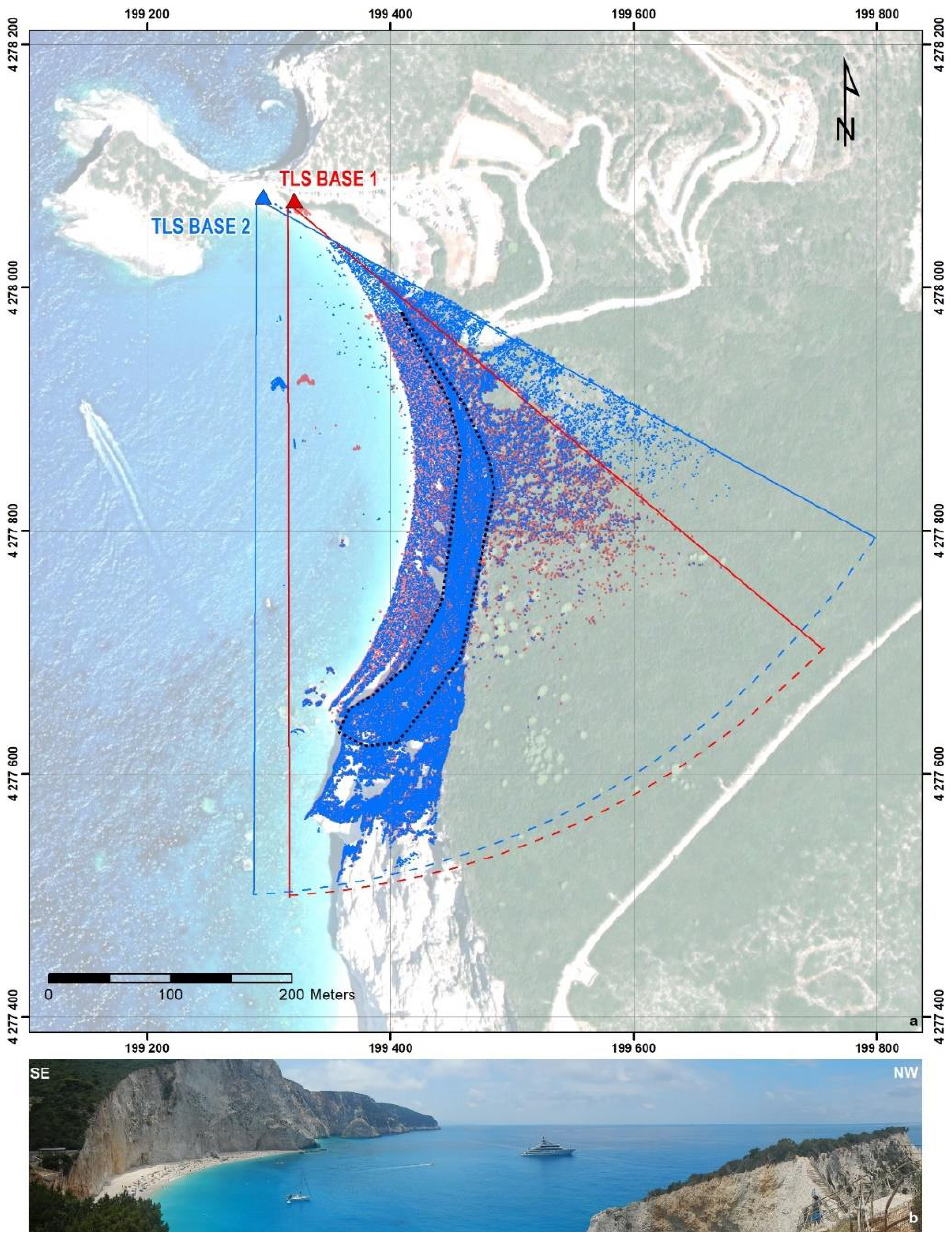
Figure 6. ( a ) Spatial location of the TLS point clouds acquired from two base stations (in red and blue colors). The black dots delineate the common scanned area of the steep slope with the minimal shadowing effect. ( b ) Panoramic view of Porto Katsiki beach during the fieldwork. Note the scanning equipment established at the bottom right (TLS base 2).